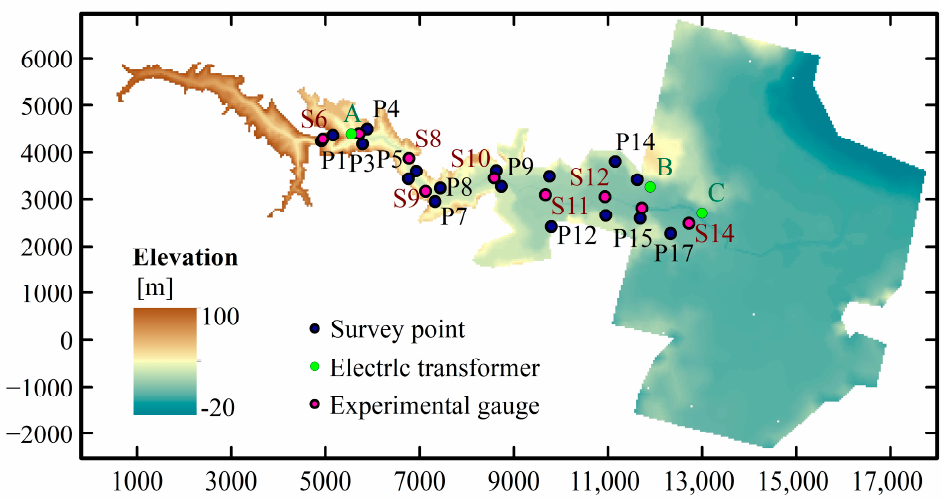
Figure 15. Malpasset dam break: topography and location of experimental points.